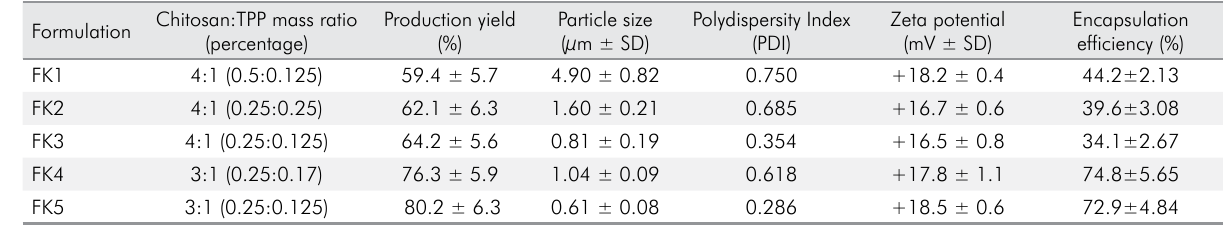
Table. The production yield, encapsulation efficiency, particle size, and size distribution of hPTH-loaded chitosan microspheres (n = 3). Chitosan:TPP mass ratio Production yield Particle size Formulation (percentage) (%) (µm ±